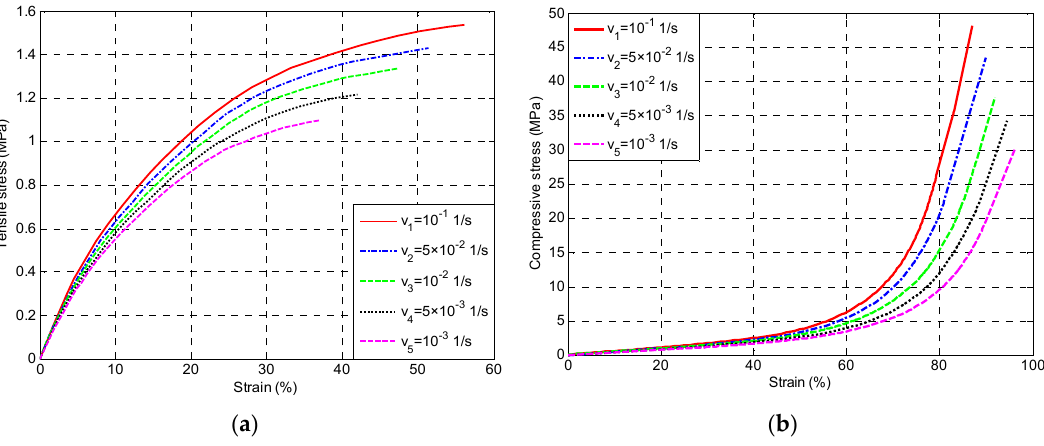
Figure 1. ( a ) Tensile and ( b ) compressive stress–strain curves for five different deformation rates.